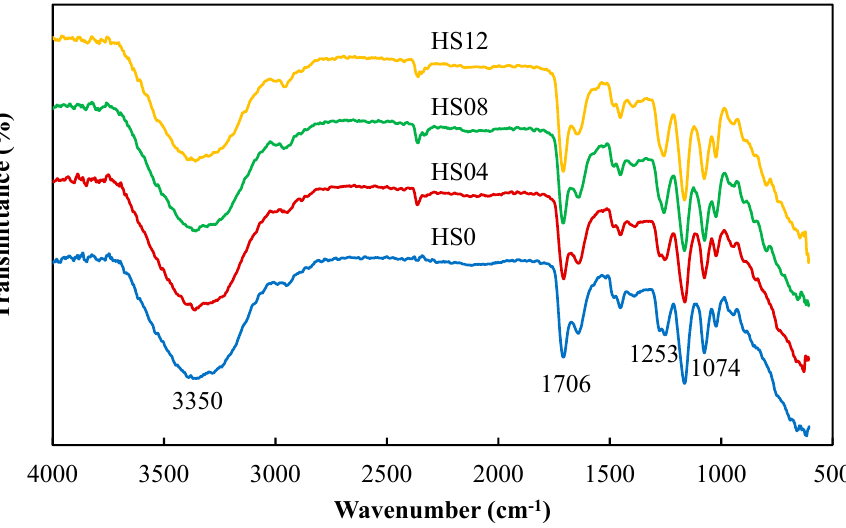
Figure 12. The FTIR spectra of HS- series SiNPs-containing contact lenses.